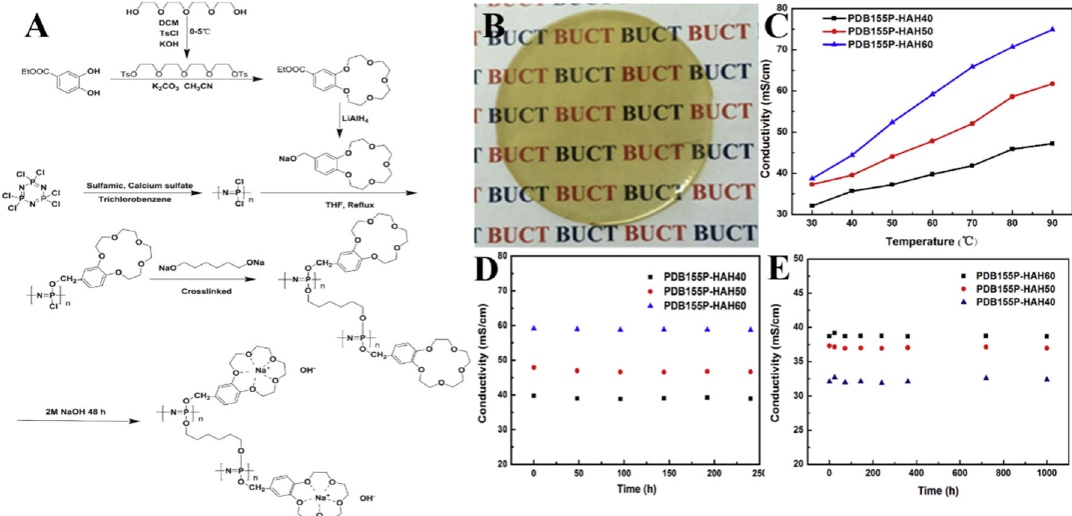
Figure 5. ( A ) The preparation progress of membrane. ( B ) The picture of membranes. ( C ) AEMs ionic conductivities at 30–90 °C under RH (relative humidity) of 100%. ( D ) AEMs alkaline stability in 4 mol/L NaOH at 60 °C for 10 days. ( E ) AEMs alkaline stability in 2 mol/L NaOH at room temperature for 1000 h. Taken with permission from [50].